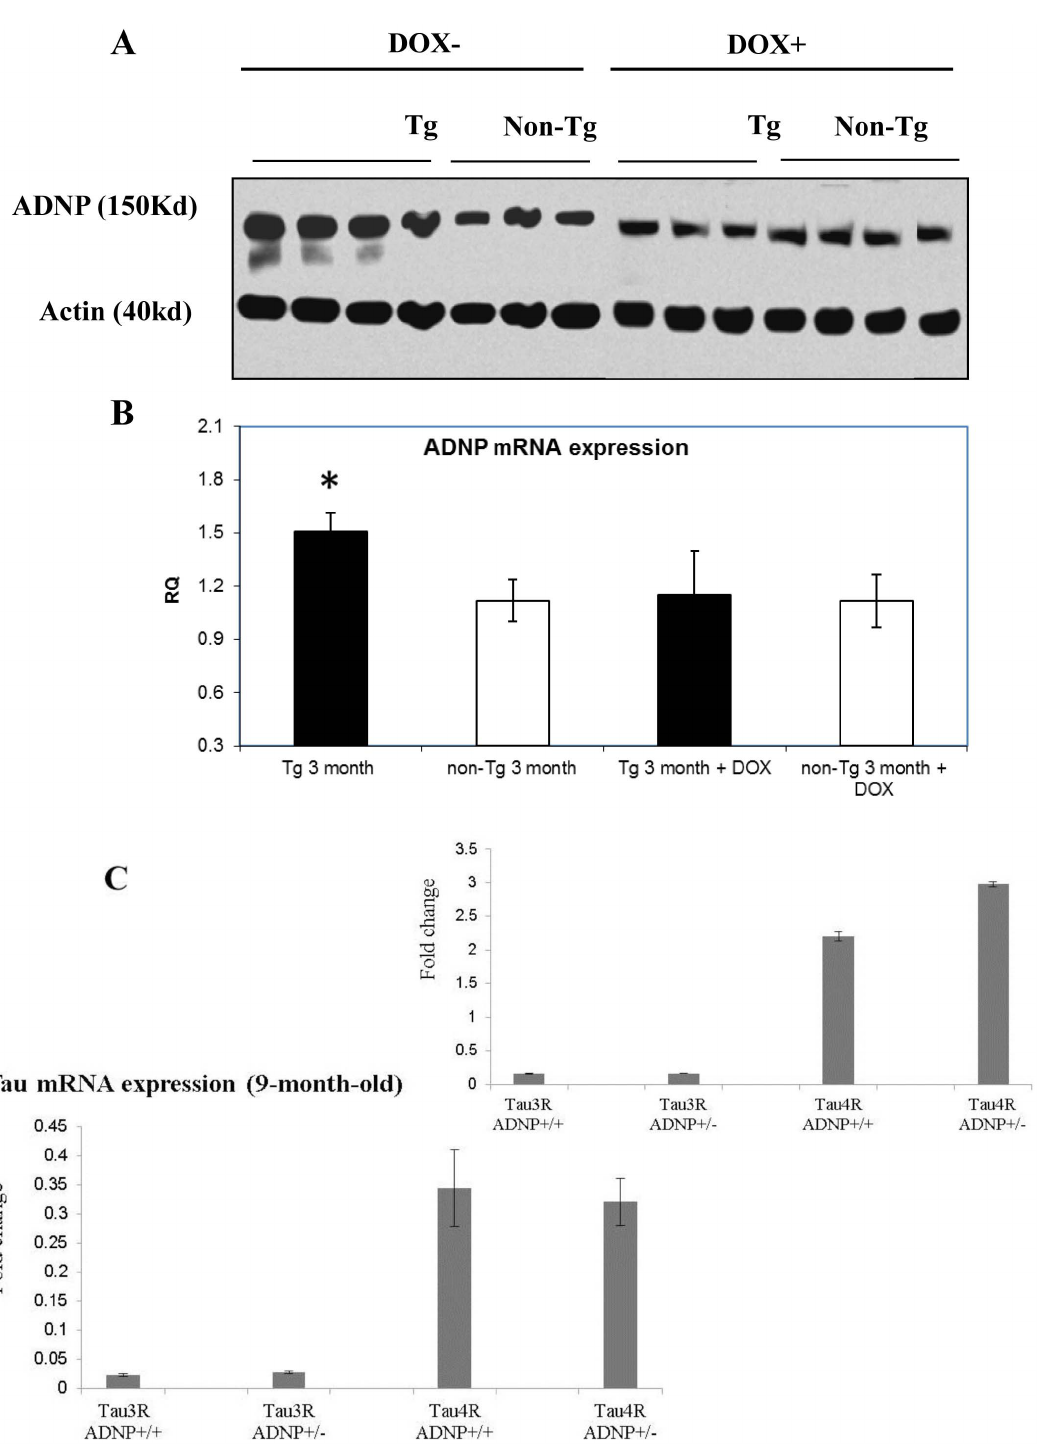
Figure 3. Doxycycline treatment which shuts down transgene expression normalizes ADNP and tau 3R expression, while ADNP deficiency may regulate tau isotype expression. A] ADNP expression with doxycycline: Western blot analysis is depicted as in Fig. 2A, on nuclear extracts with ADNP antibodies. When the ADNP/actin ratios were calculated as in Fig. 1, a significant reduction of ADNP/actin ratio was observed following doxycycline treatment, correlating ADNP expression to tau transgene expression (* p , 0.05). Five mice were used per an experimental group; each gel lane includes one mouse extract with 3-4 mice representing an experimental group. B] ADNP mRNA quantification. The ADNP mRNA amount in each sample (n=5/experimental group) was calculated using the correlated HPRT mRNA amount of the same sample. A comparison of Tg and non-Tg as well as Dox + treatment is shown as for the proteins (panel A, above), (* p , 0.05). C] Trend toward deregulation of tau expression in the cortex of 2-month-old ADNP + / 2 mice. The expression of mouse tau 3R and mouse tau 4R (4–5 female mice, cerebral cortex/